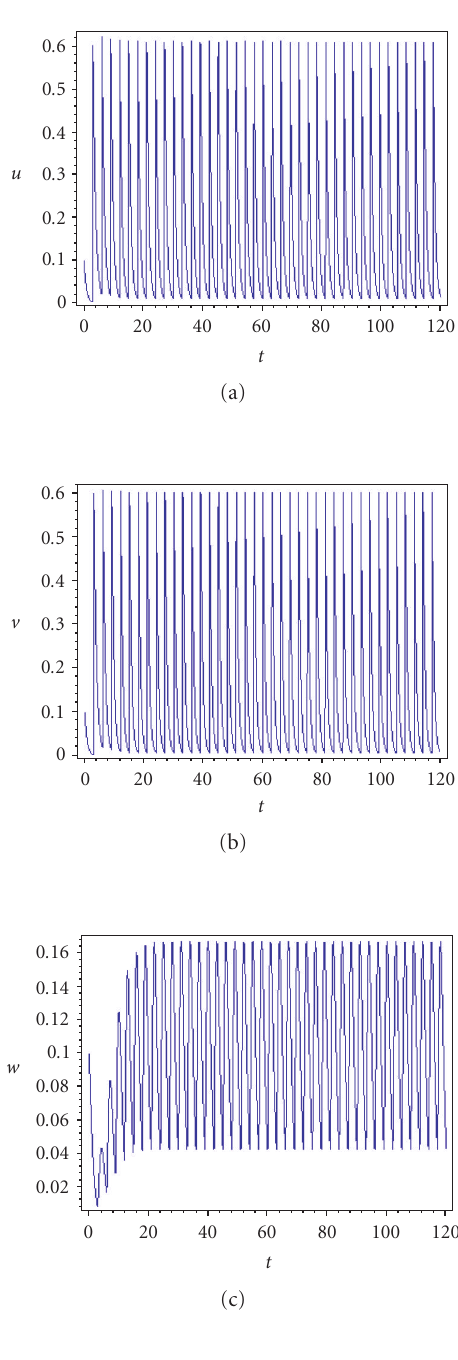
Figure 5.2. Time series of the system (3.1) with pulse, A = 5, B = 20 / 3, p = 0 . 6, Q = 0 . 6, and T =